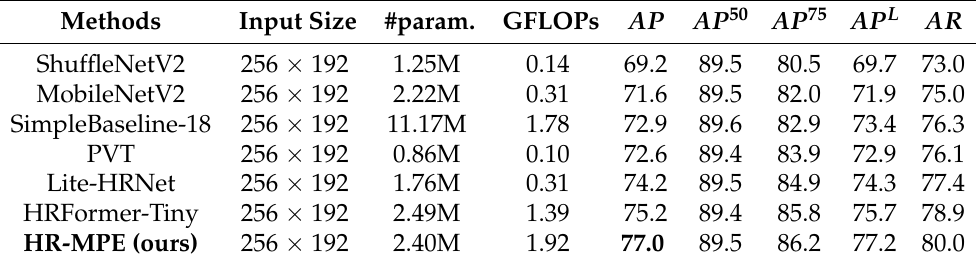
Table 4. Comparison on the macaque monkey test set. The volume of parameters and FLOPs for the pose estimation network are measured without animal detection and keypoint